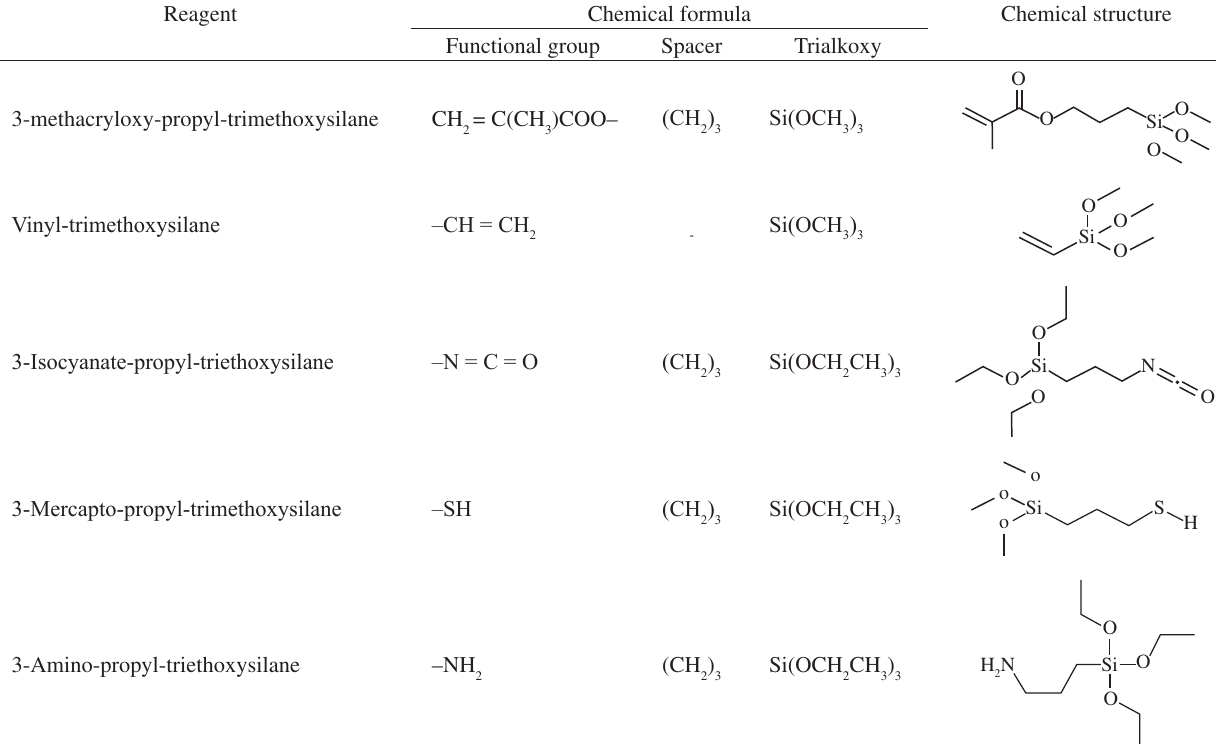
Table 1. Organosilanes surface